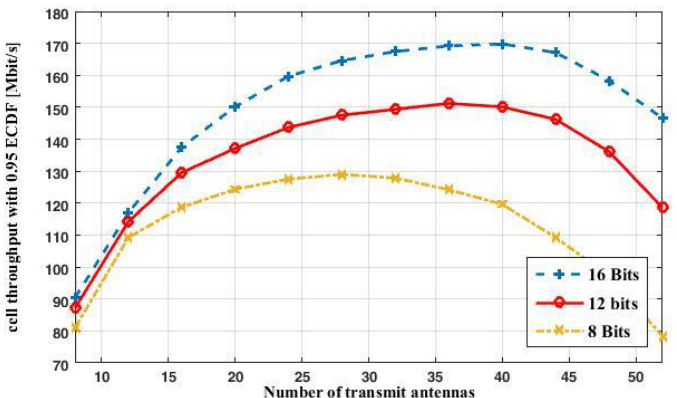
Figure 5. The considered system with Distributed Antenna System (DAS) configuration, under different numbers of transmit antennas and feedback bits of 8, 12, and 16.